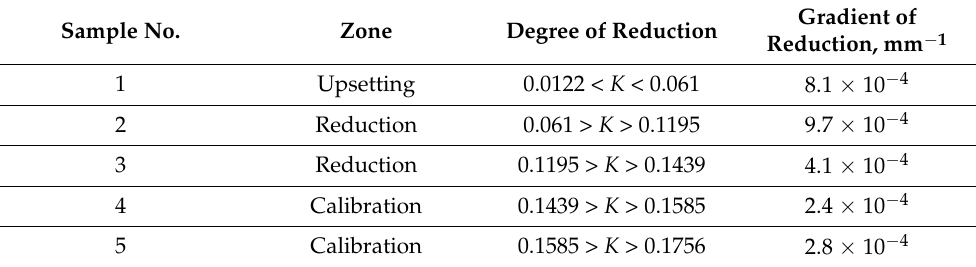
Table 1. Degrees and gradients of reduction at the rolling